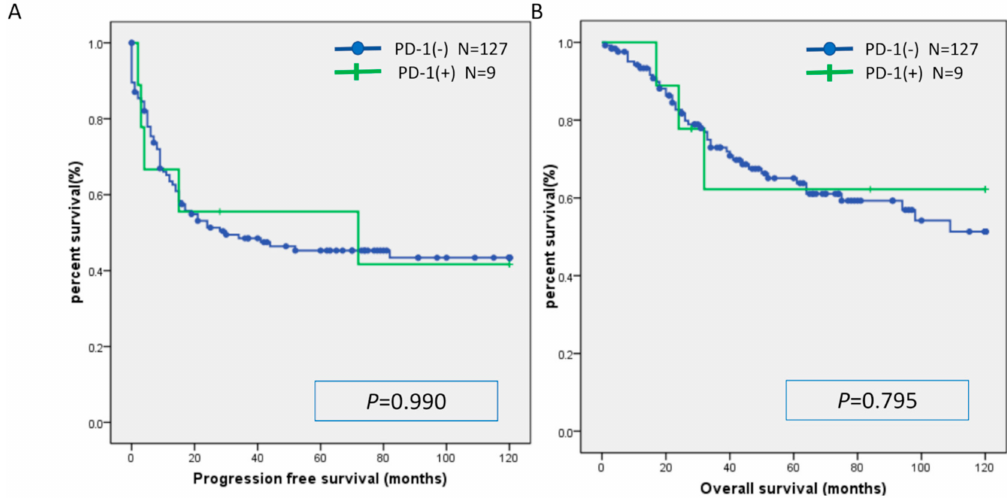
Figure 4. Kaplan-Meier analysis of progression-free survival ( A ) and overall ( B ) survival between the PD-1( + ) group and PD-1( − )